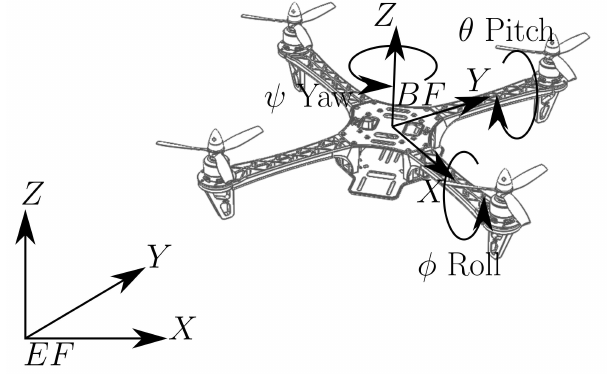
Figure 1. Euler angles.